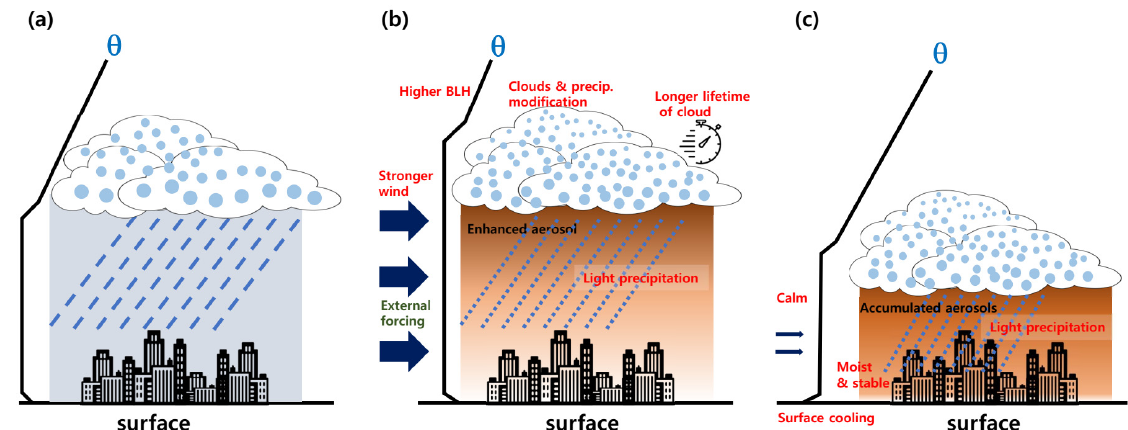
Figure 7. Schematic diagram of aerosol-meteorological interactions in Korea. ( a ) normal condition, ( b ) clouds and precipitation response to aerosol external forcing representing the first period (12–13 January), and ( c ) enhanced haze due to the meteorological condition modified by aerosol-cloud-precipitation interactions indicating the second period (15–16 January).